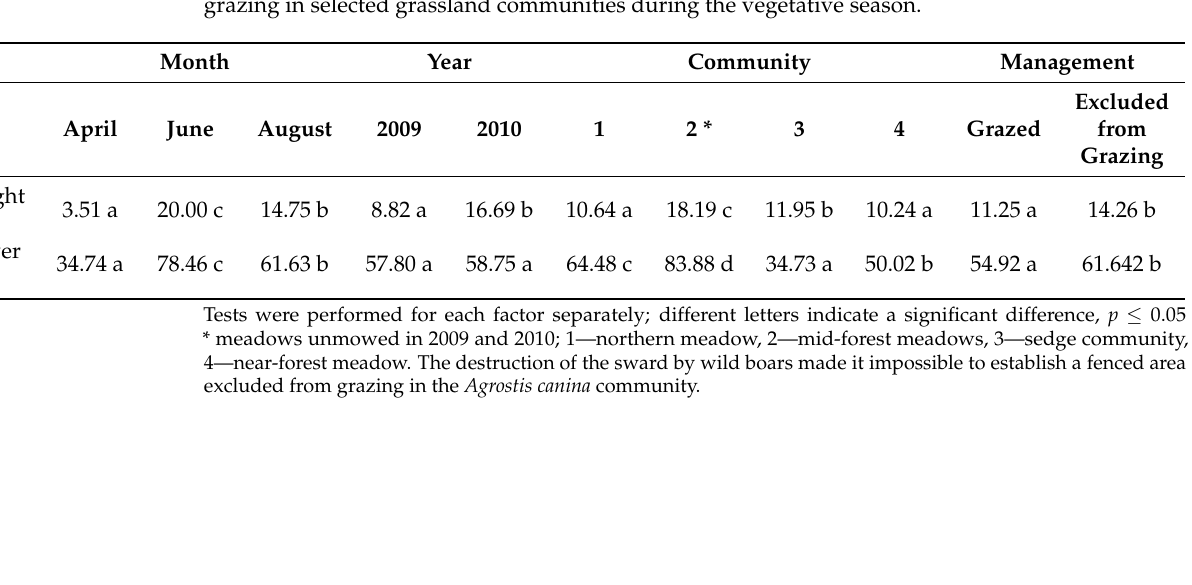
Table 4. Average sward height [cm] and sward cover [%] in grazed areas and in areas excluded from grazing in selected grassland communities during the vegetative